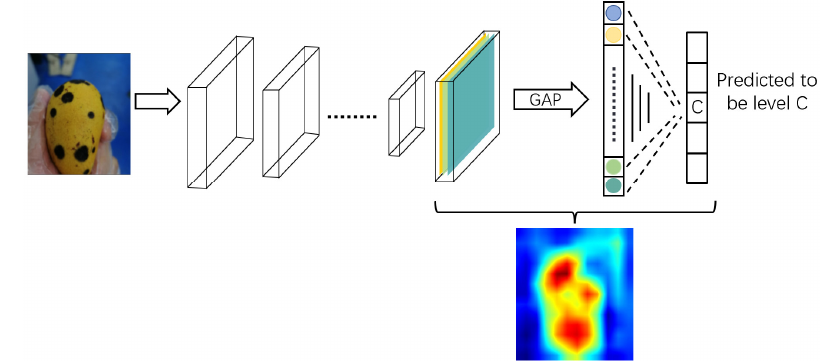
Figure 4. CAM generation